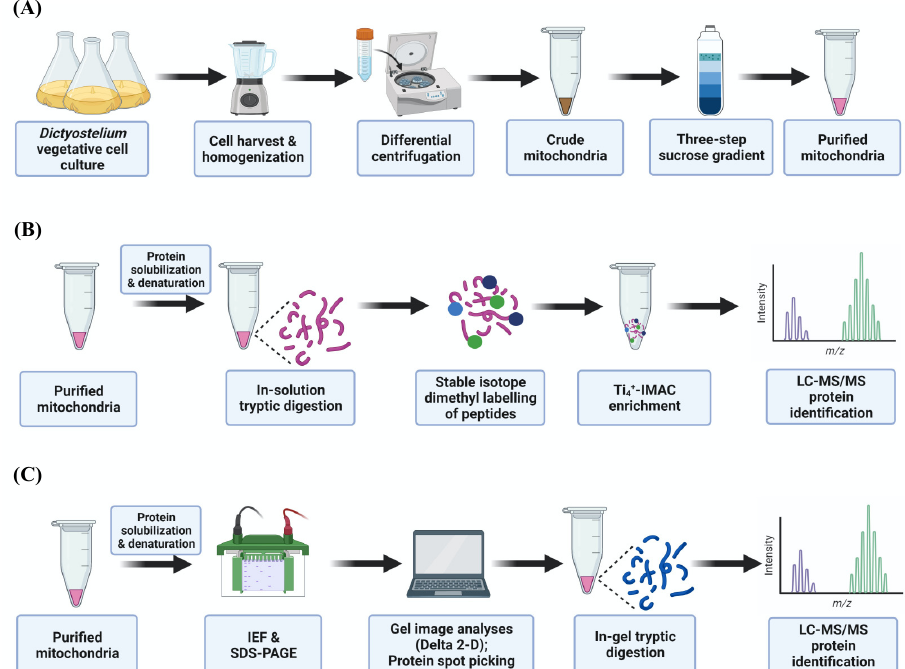
Figure 1. Experimental workflow used in this study. ( A ) Vegetatively growing Dictyostelium discoideum wild-type (WT) and AMPK α -overexpressing (HPF444) cells were harvested at the exponential phase of growth and subjected to isolation and purification of mitochondria by differential centrifugation and sucrose density gradient centrifugation, respectively; ( B ) purified mitochondria were subjected to solubilization and tryptic digestion. Phosphopeptides were enriched via immobilized titanium (IV) ion affinity chromatography (Ti 4+ -IMAC) and identified by LC-MS/MS; ( C ) purified mitochondrial fractions were solubilized and resolved by 2D-PAGE (IEF/SDS-PAGE) electrophoresis. Proteins displaying a significant difference in abundance were picked from the gels, designed for in-gel tryptic digestion and peptide identification via MS/MS. More details on the survey design of the experiment are given in the Material and Methods as well as Results sections. Created with BioRender.com.